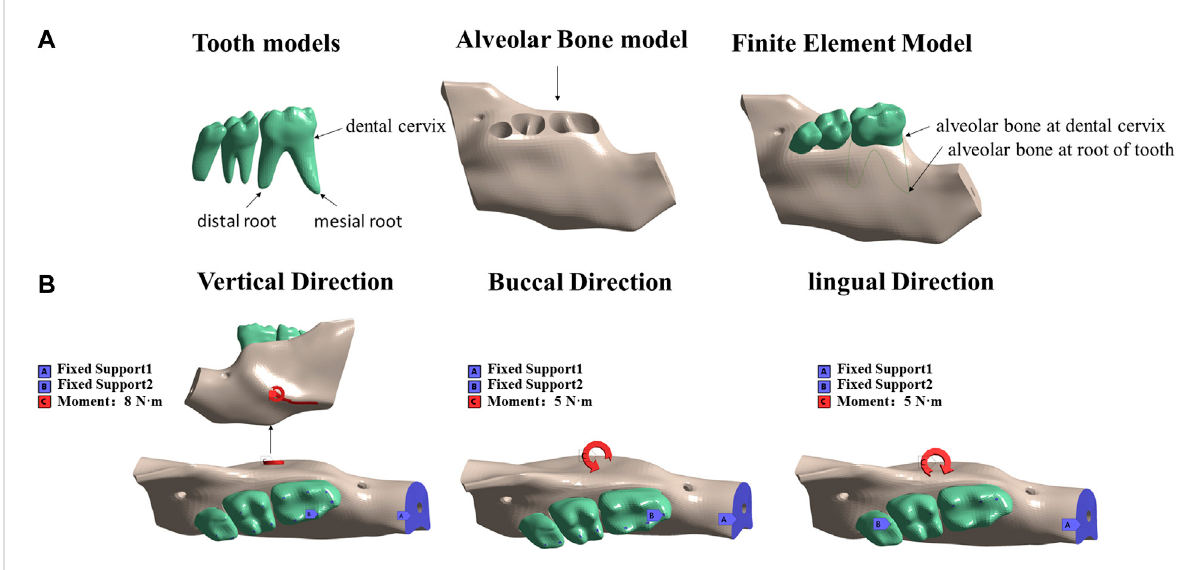
FIGURE 2 Resulting solid three-dimensional fi nite element model obtained in ANSYS: (A) tooth model, alveolar bone model, and intact model; (B) three force directions; fi xed and stressed